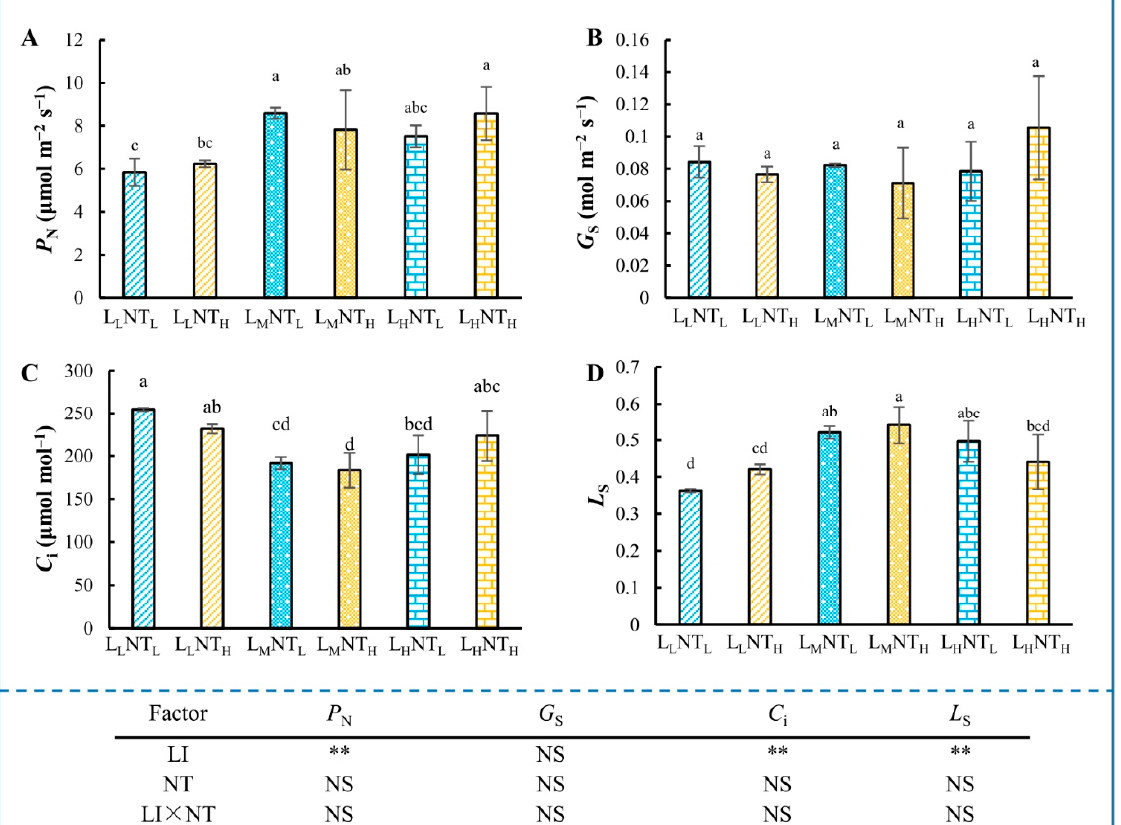
Figure 3. Effect of light intensity (LI) and night temperature (NT) on photosynthetic traits including P N , net photosynthetic rate ( A ) G S , stomatal conductance ( B ) C i , intercellular CO 2 concentration ( C ) and L s , stomatal limitation ( D ) of cherry tomato seedlings. Abbreviations of different treatments were as described in Figure 1. The symbol “NS” and “**” indicate no significance at p < 0.05, and significant level at p < 0.01 by Duncan’s test, respectively. Different letters on bars for the same parameter indicate statistically significant differences ( p <